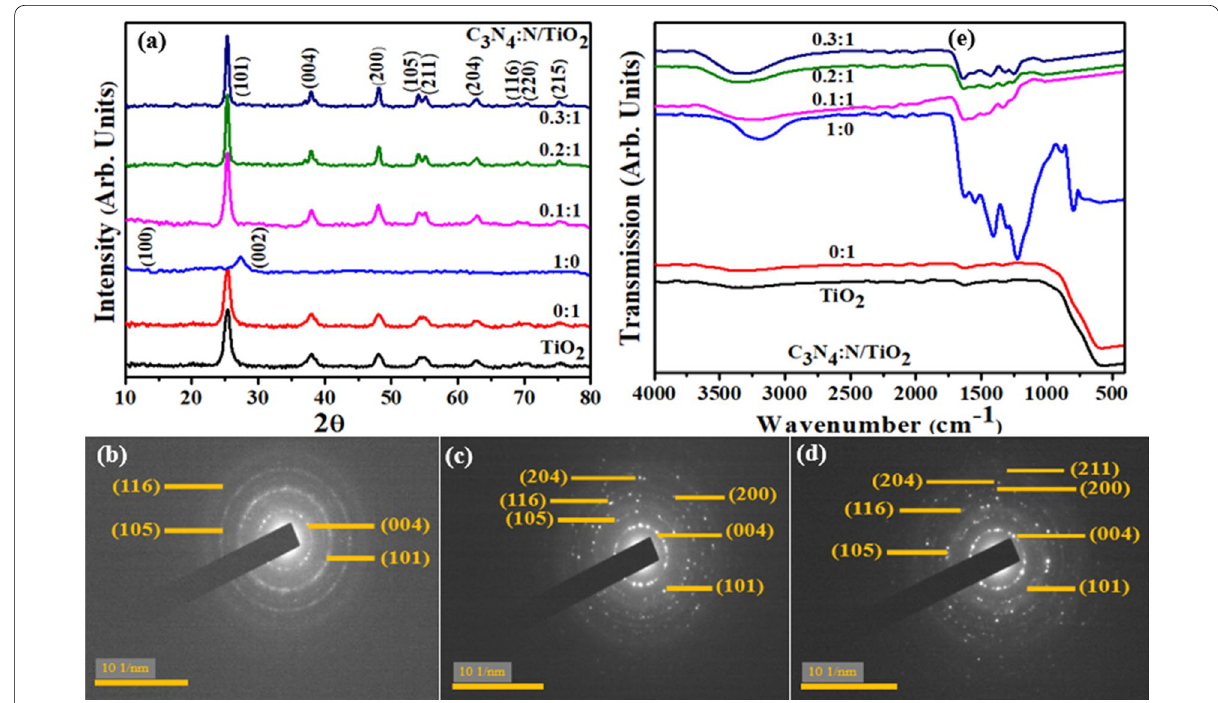
Fig. 2 a XRD pattern. b FTIR spectra. c – e SAED profiles of as‑synthesized co‑doped TiO 2 . c TiO 2 . d 0:1. e